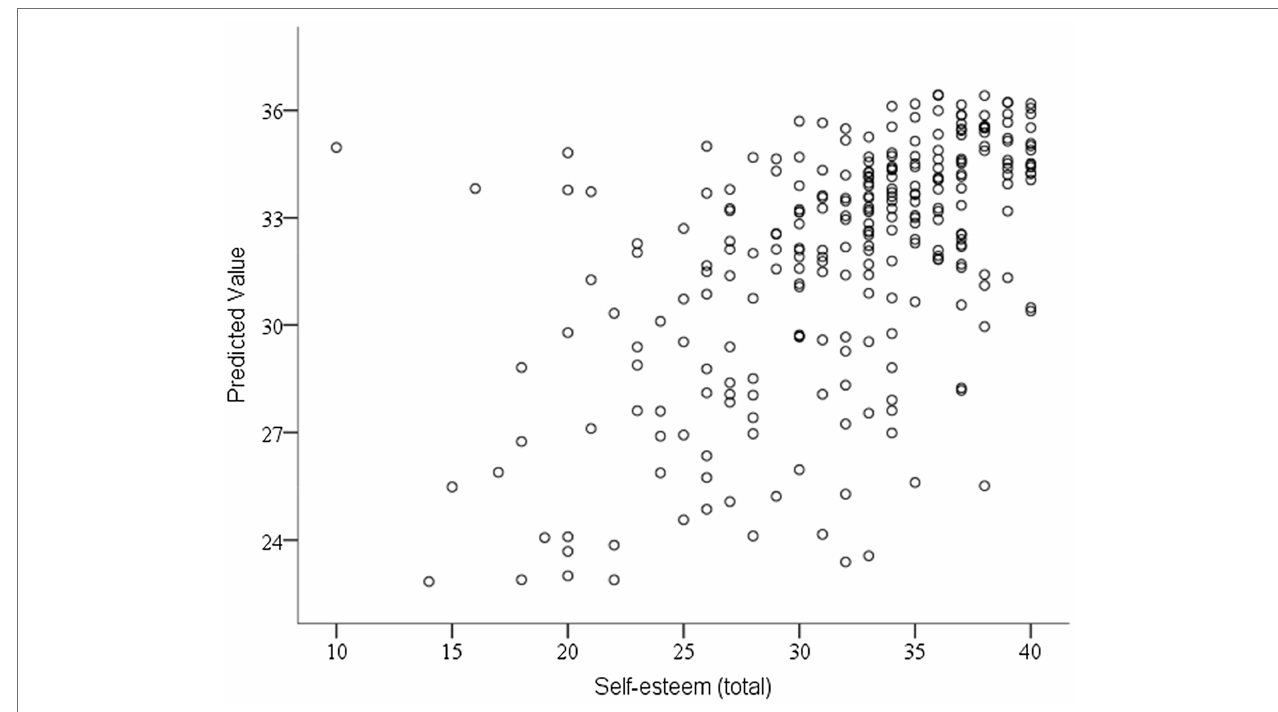
FIGURE 2 | Relationship between what is predicted and what is observed by the model. Source: Own